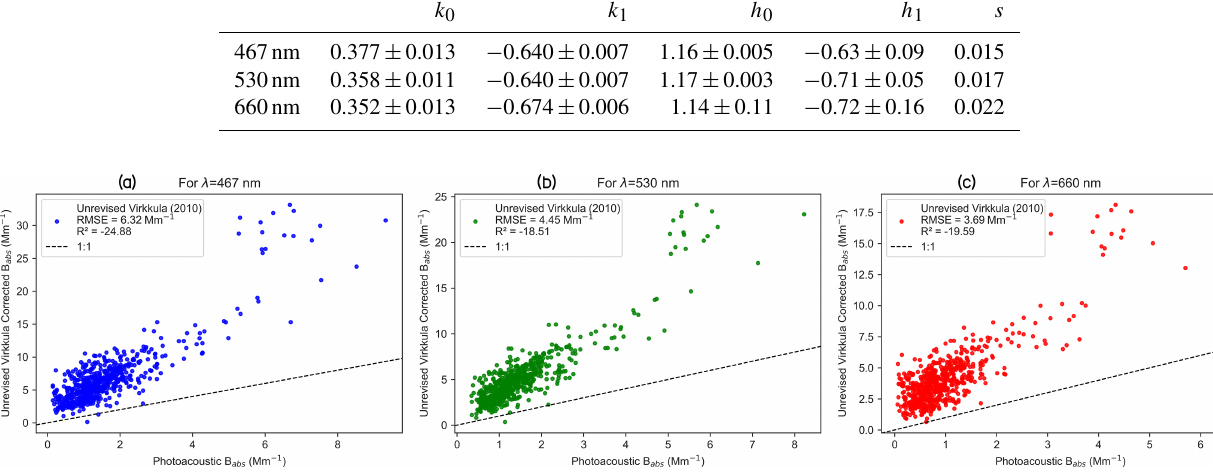
Figure 2. Comparison between PSAP absorption coefficients, corrected for using the Virkkula (2010) algorithm with unrevised coefficients and the reference PASS absorption coefficients measured at the SGP site corresponding to the (a) 467nm, (b) 530nm, and (c) 660nm